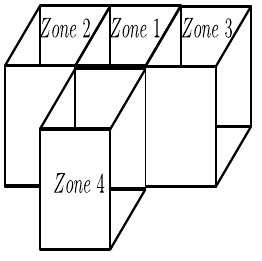
Figure 8. Four thermal zones.